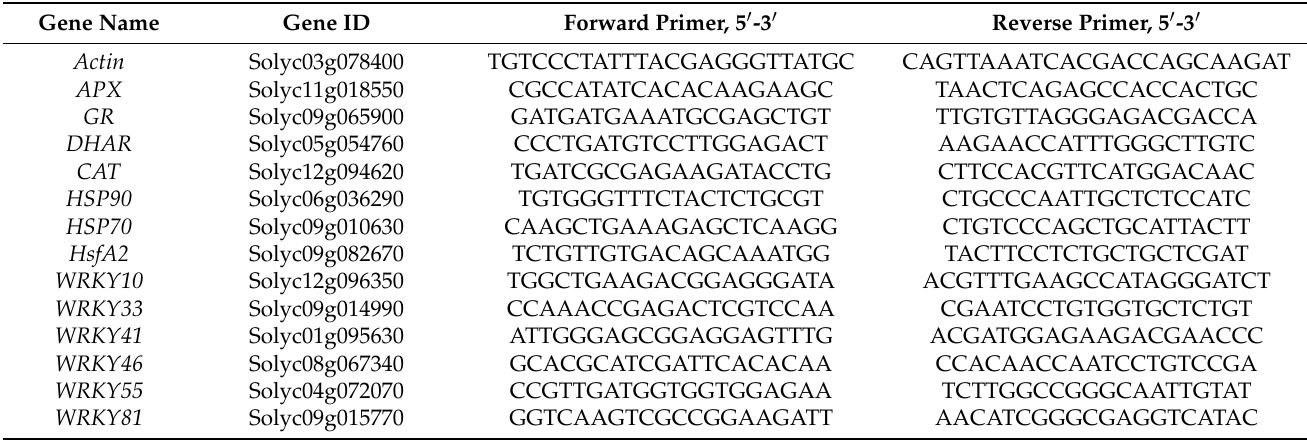
Table 1. Gene-specific primers designed for qRT-PCR